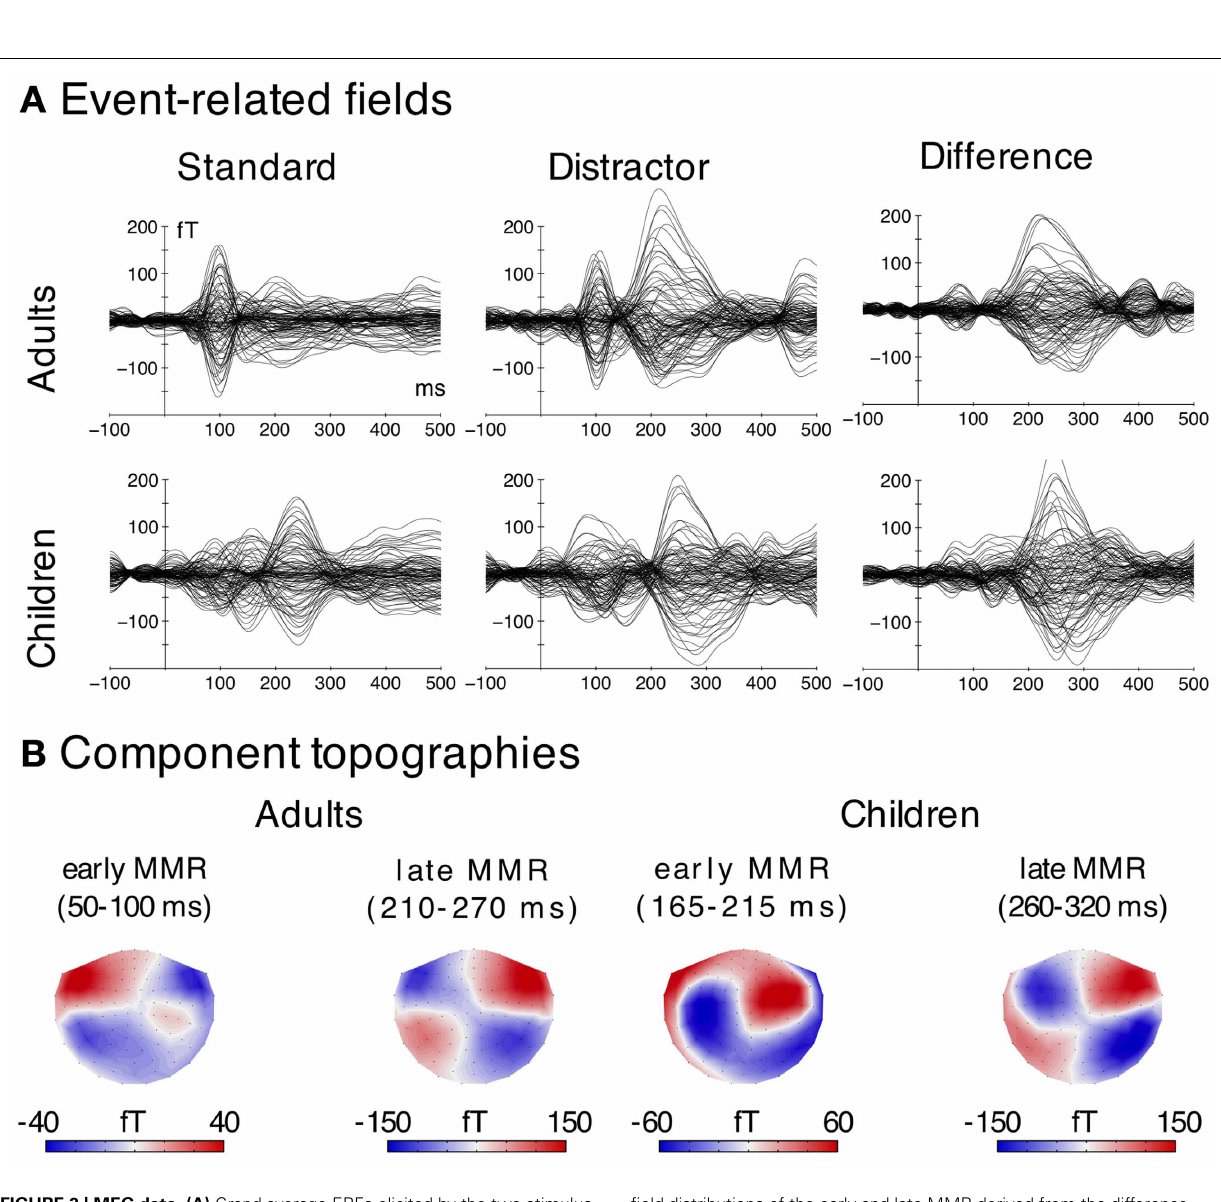
field distributions of the early and late MMR derived from the difference waves (distractor-minus-standard). Note that for this figure only magnetometer channels were